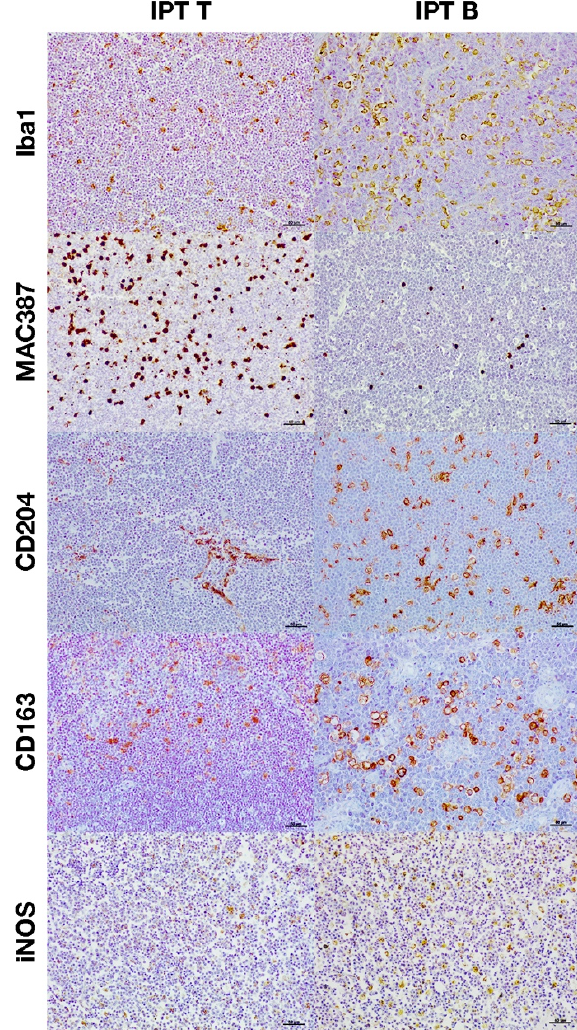
Figure 3. Immunohistochemical expression of the different macrophage markers according to the immunophenotype.